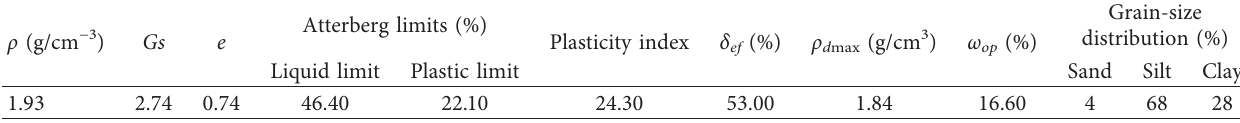
Table 1: Basic physical properties of the tested soils.